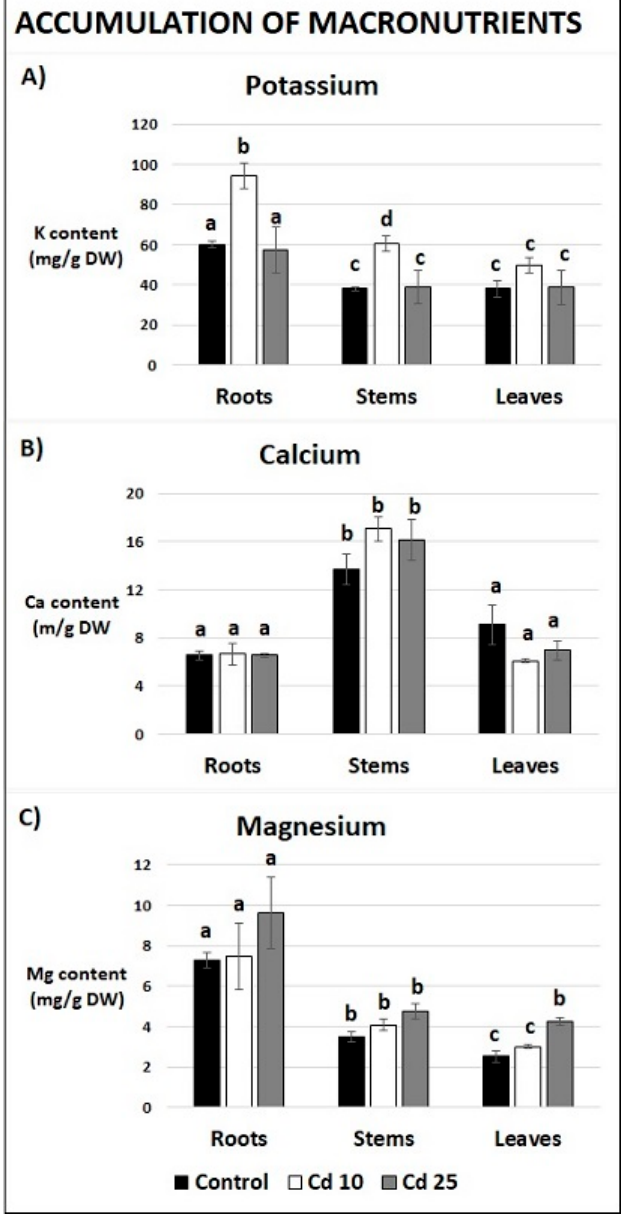
Figure 6. Content of macronutrients, potassium ( A ), calcium ( B ) and magnesium ( C ) in plants after 7 days of recovery. Results are the means of three independent experiments ± SE. Results showing no statistically significant differences by p = 0.05 are marked with the same letter.